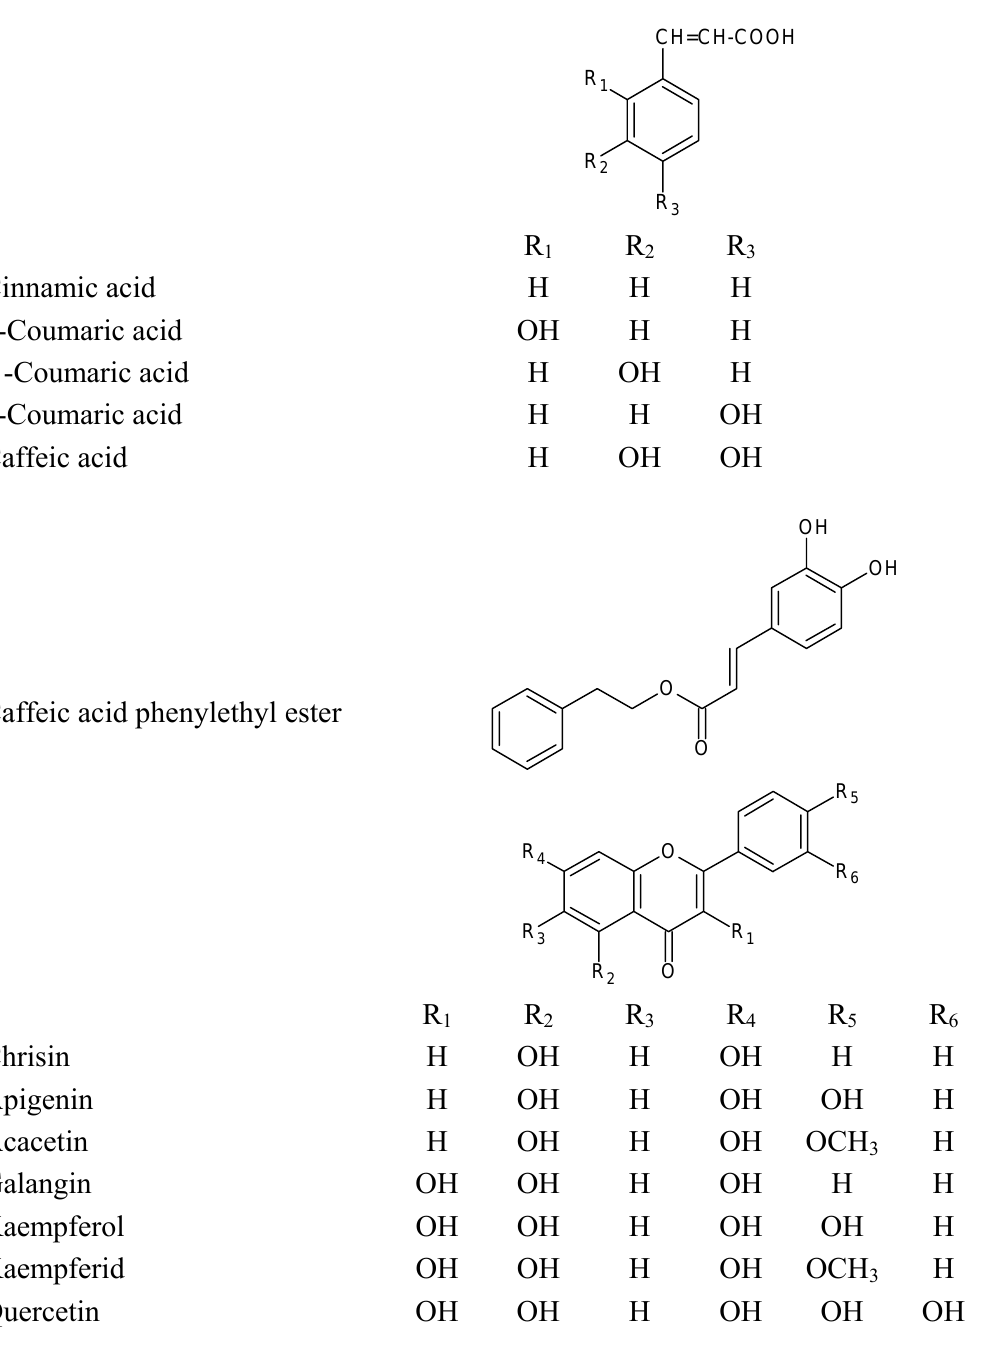
Figure 1. Chemical structures of the phenolic compounds used in this